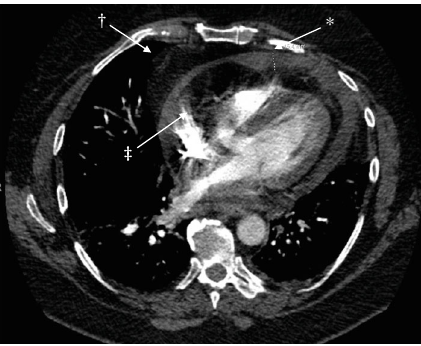
Figure 3: CT pulmonary angiography. Findings: ∗ pericardial e ff usion: 15.4mm (shown). † pericardial mass; ‡ epicardial fat.